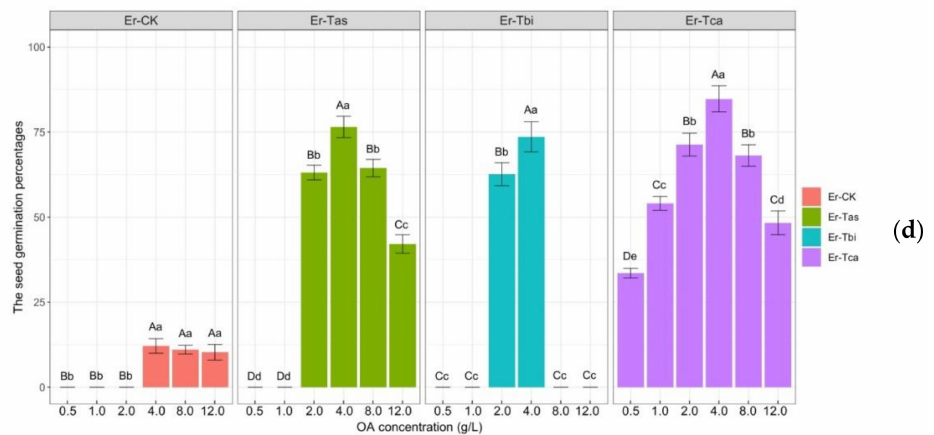
Figure 6. The effects of different concentrations of OA on seed germination 60 days after cultivation. ( a ) The GI values of C. mannii with Tca (Cm-Tca), Tas (Cm-Tas), Tbi (Cm-Tbi), and CK (Cm-CK). ( b ) The GI values of E. radicans with Tca (Er-Tca), Tas (Er-Tas), Tbi (Er-Tbi), and CK (Er-CK). ( c ) The germination percentages of C. mannii with Tca (Cm-Tca), Tas (Cm-Tas), Tbi (Cm-Tbi), and CK (Cm-CK). ( d ) The germination percentages of E. radicans with Tca (Er-Tca), Tas (Er-Tas), Tbi (Er-Tbi), and CK (Er-CK). In each panel, concentrations with same letters are not significant; concentrations with different capital letters are extremely significantly different ( p < 0.001) and lowercase letters are significantly different ( p < 0.05) based on Tukey